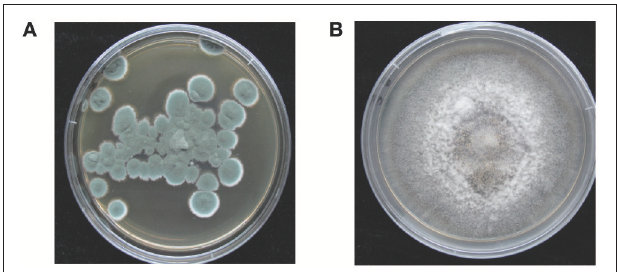
FIGURE 2 | Morphology of P. polonicum hy4 (A) and C. gloeosporioides Cg01 (B) on potato dextrose agar.